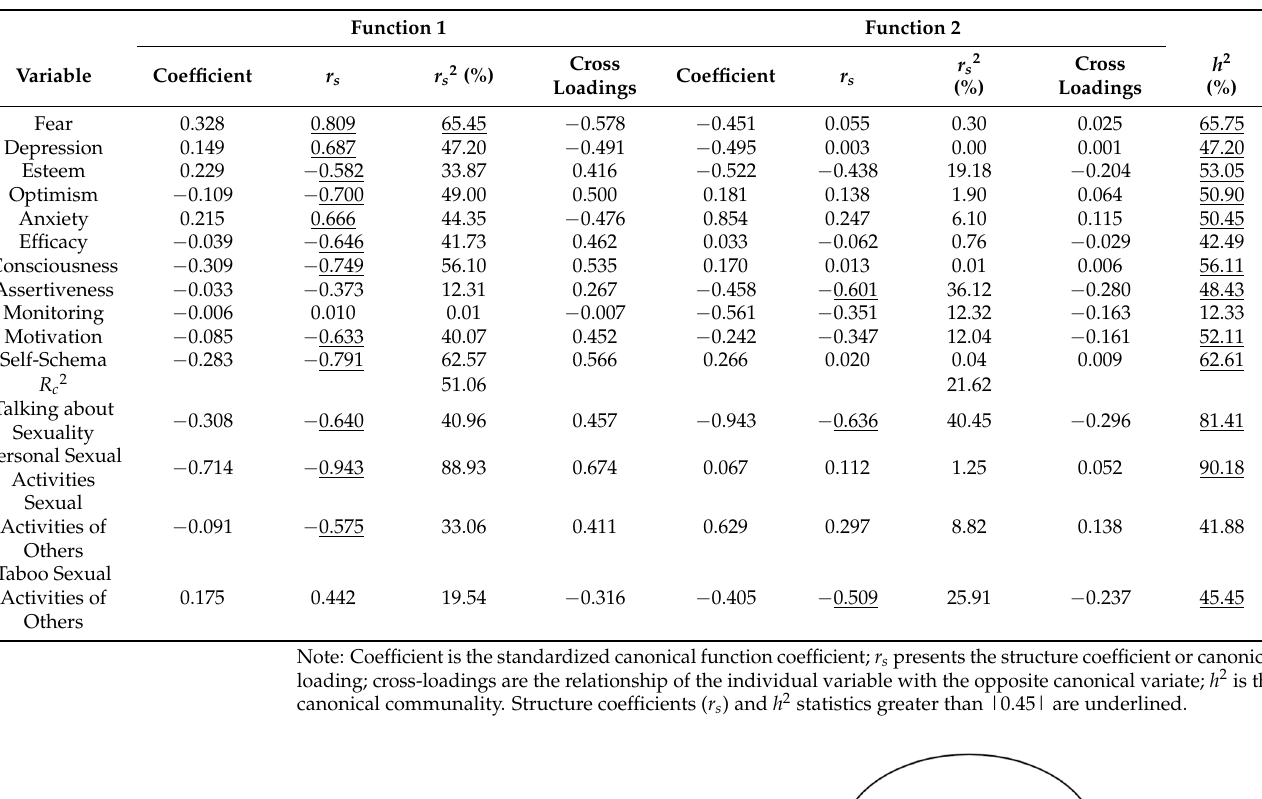
Table 4. Canonical solution for relationship between sexual self-concept and comfort with sexuality for functions 1 and 2 ( n = 304).